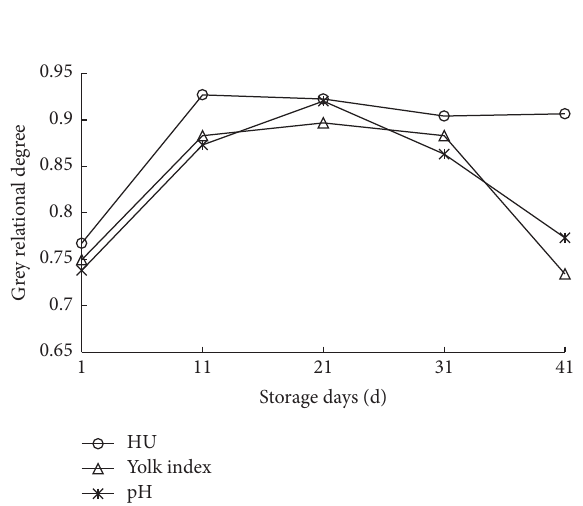
Figure 1: Te changing trend in the relative gray relationship degree between each egg freshness indicator and ovomucin con- centration for various storage days.